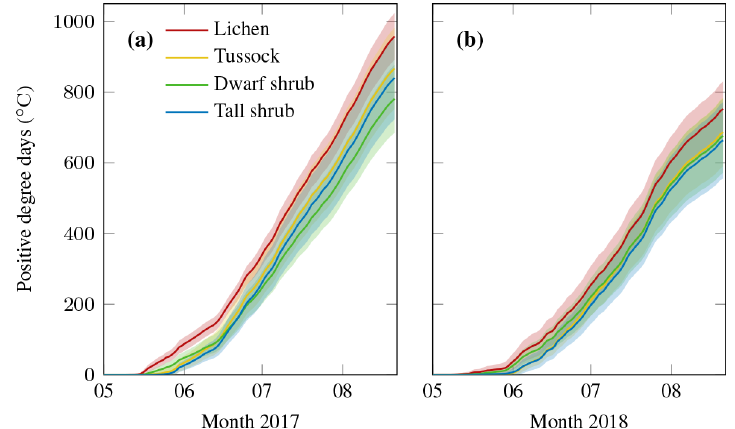
Figure B3. Cumulative positive degree days of topsoil temperature below different vegetation types; the lines indicate the mean of all series per type, and the shaded areas represent the mean plus or minus the standard deviation; (a) 2017 and (b) 2018.